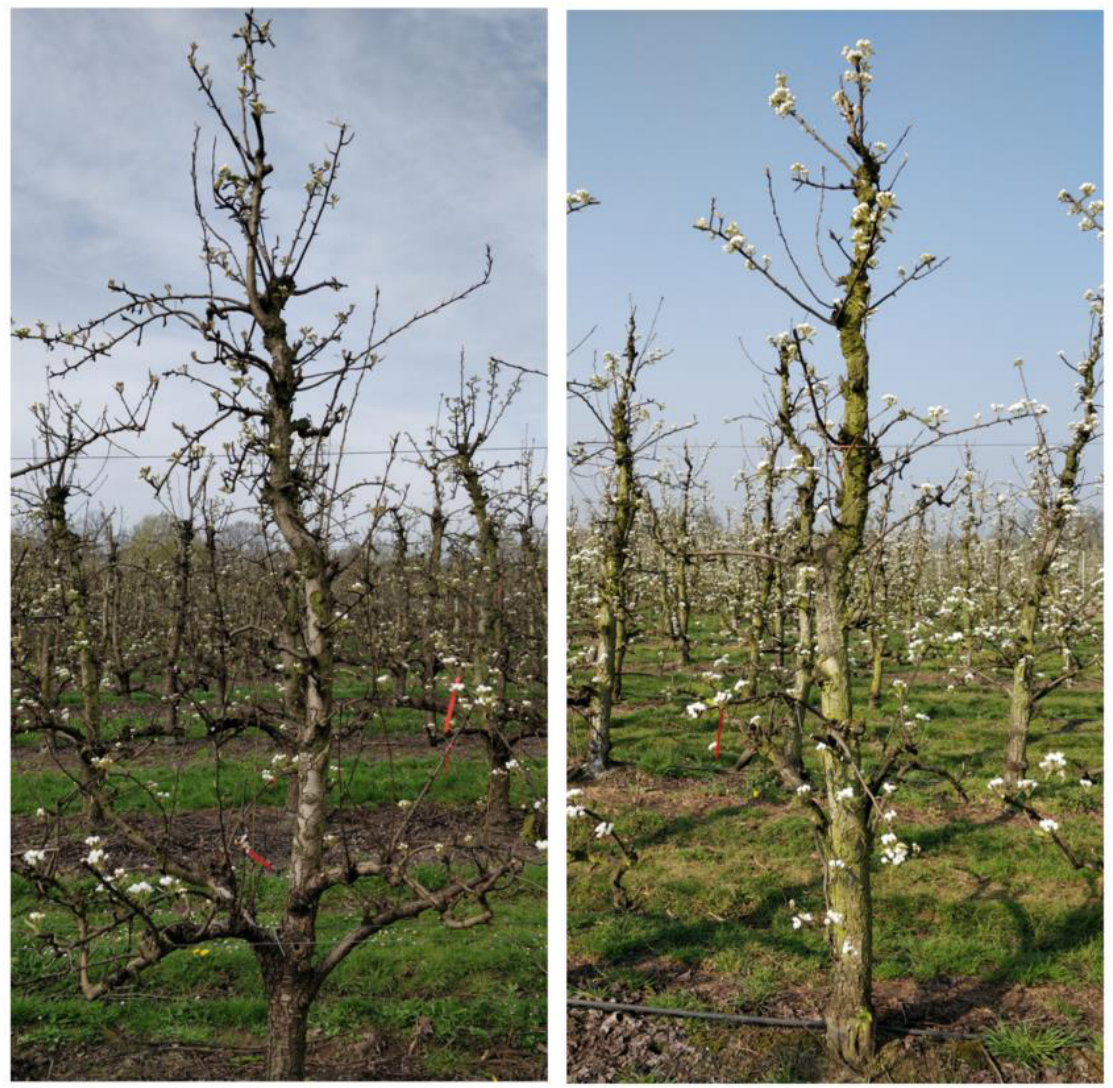
Figure A4. Tree architecture of pruned trees in Wimmertingen (plot 5C) and Rummen (plot 1D). 227